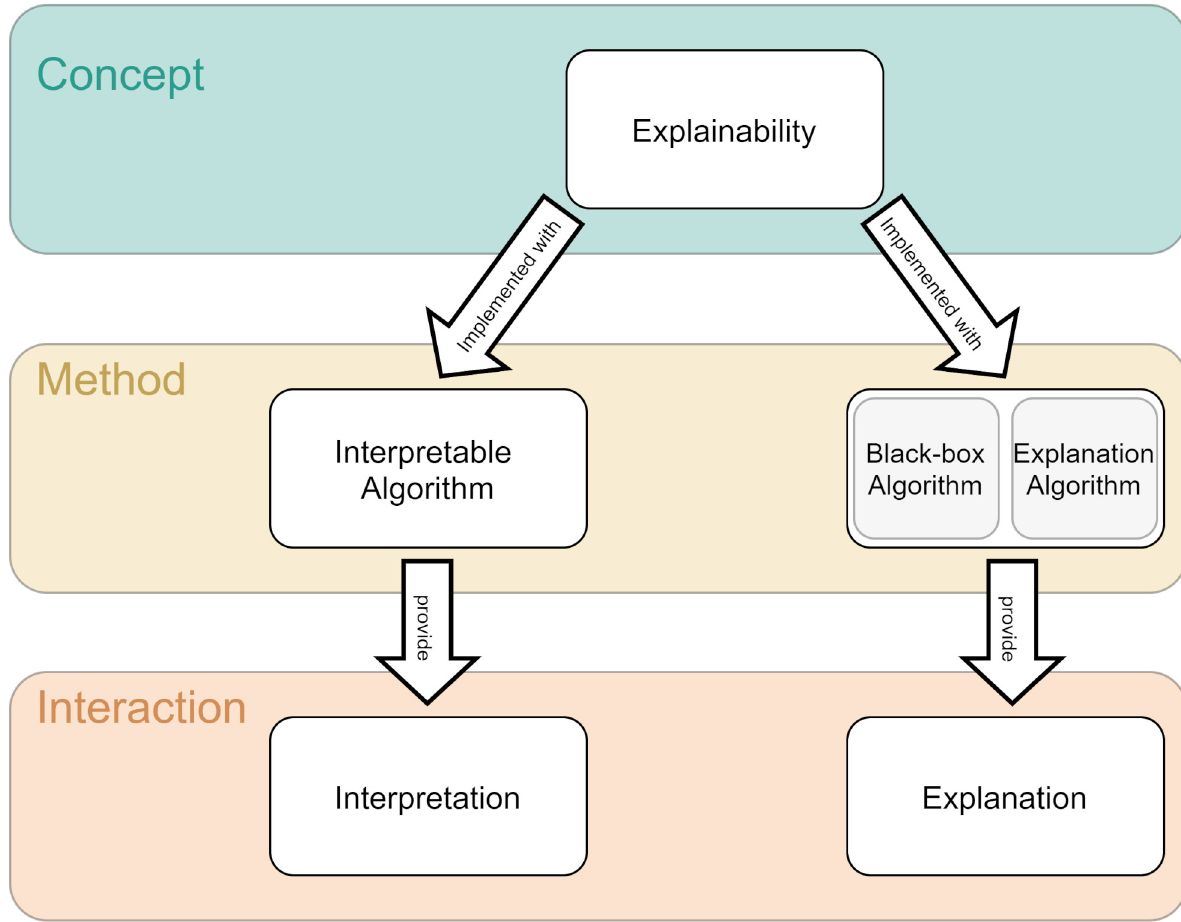
Fig 1. Terminology. Given that there is no commonly accepted terminology, we defined the following terms for this work: When referring to the general concept of explaining machine learning models, we will call it explainability. This can be achieved either by using inherently interpretable algorithms (which provide interpretations) or by using a black-box algorithm and an additional explanation algorithm (which provides explanations). These interpretations or explanations are what the user is interacting with.